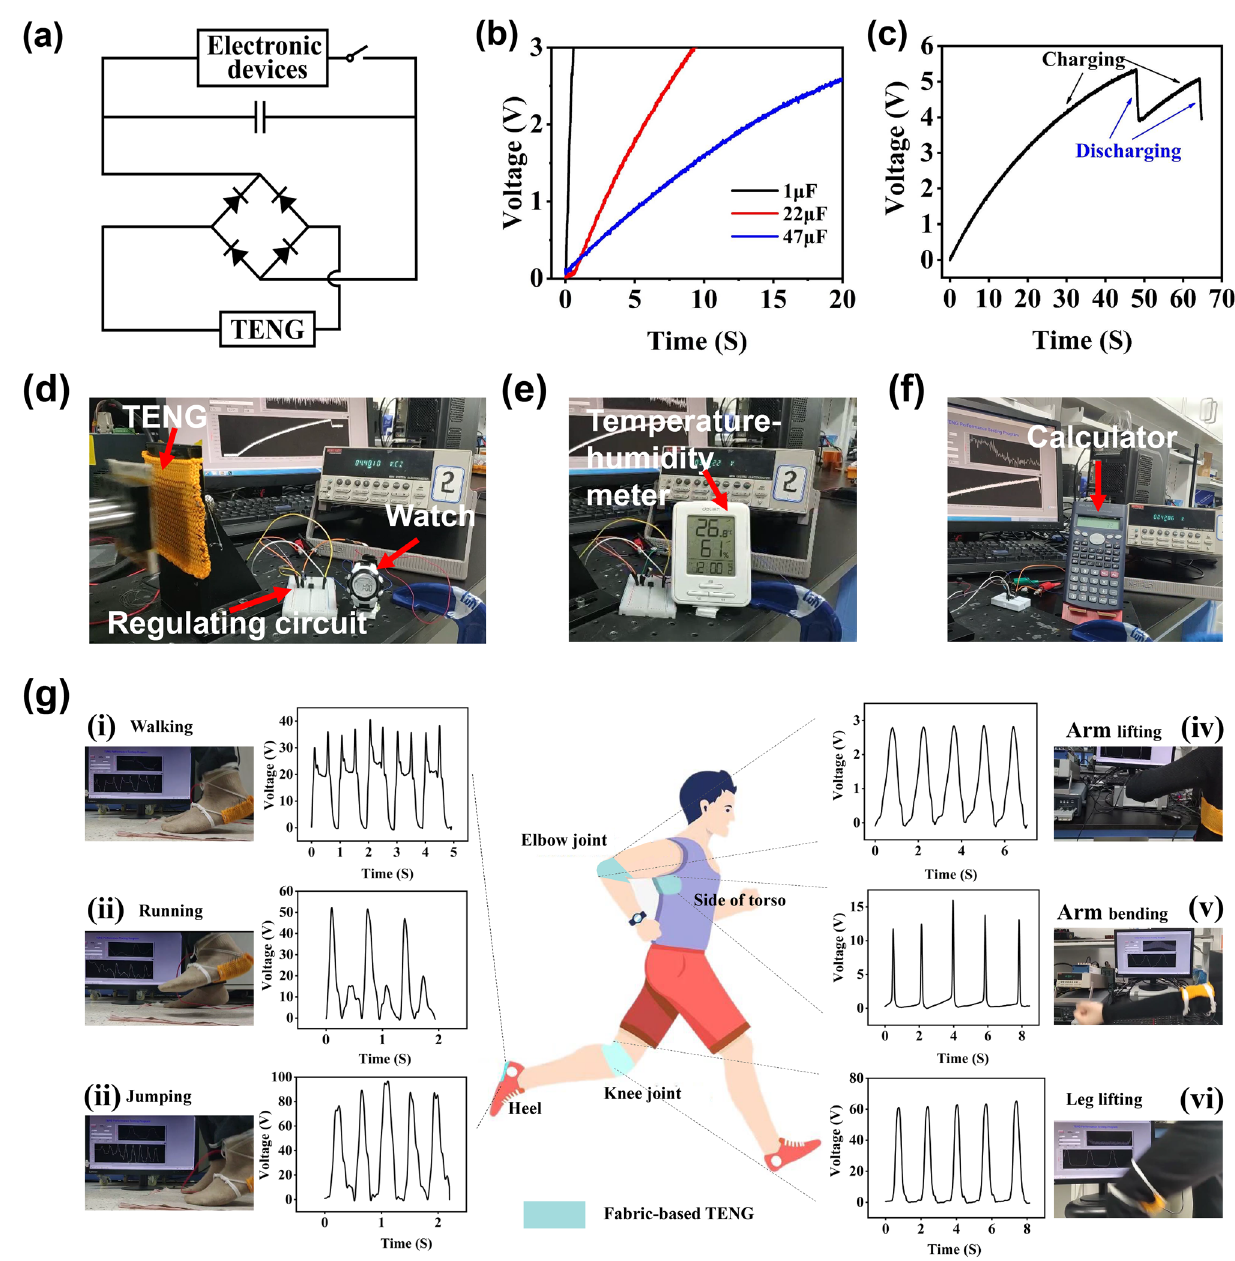
Fig. 6 The developed applications of fabric-based TENG. a Diagram of fabric-based TENG charging capacitors and powering electronics. b Charging curve of commercial capacitors by pressing the fabric-based TENG. c Real-time test of the capacitor voltage and powering a watch. d A watch, e a temperature–humidity meter, and f a calculator are driven by pressing the fabric-based TENG. g Testing photograph and output voltage signals of fabric-based TENG as self-powered sensor fixed to various parts of human body (heel, side of torso, elbow, and keen joint) to monitor mechanical motion, (i) walking, (ii) running, (iii) jumping, (iv) arm lifting, (v) arm bending, and (vi) leg